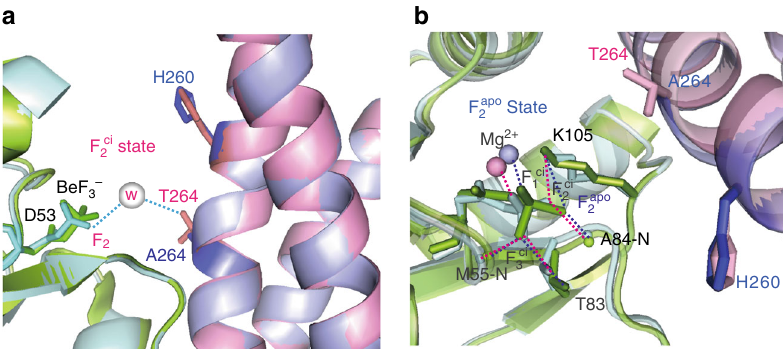
Fig. 4 Crystal structure of the T264A HK853 cp -BeF 3 – -RR468 complex reveals an “ apo ” chemical environment for the F 2 fl uorine of BeF 3 – -RR468. a Side view of the active site of the T264A HK853 cp -BeF 3 – -RR468 complex overlaid with that of the wild-type complex crystallized at pH 5.0. In the T264A complex, the BeF 3 – -RR468 substrate is shown in green and the T264A HK853 cp in pale purple, with the sidechains of H260 and A264 of T264A HK853 cp in the stick model. In the wild-type complex, the BeF 3 – -RR468 substrate is shown in cyan and HK853 cp in pink, with the sidechains of H260 and T264 of HK853 cp shown in the stick model. The interaction between the F 2 atom of BeF 3 – -D53 and the hydroxyl group of T264, bridged by the proposed catalytic water molecule (shown in the sphere model) in the wild-type complex at low pH generates the F 2 ci state. The loss of the catalytic water and its bridged interactions between the F 2 atom of BeF 3 – -RR468 and T264 and H260 in the T264A HK853 cp mutant generates a chemical environment similar to the F 2 apo state. b Top view of the active site of the T264A HK853 cp -BeF 3 – -RR468 complex overlaid with that of the wild-type complex crystallized at pH 5.0. Interactions of the fl uorine atoms in a and b are indicated by dashed